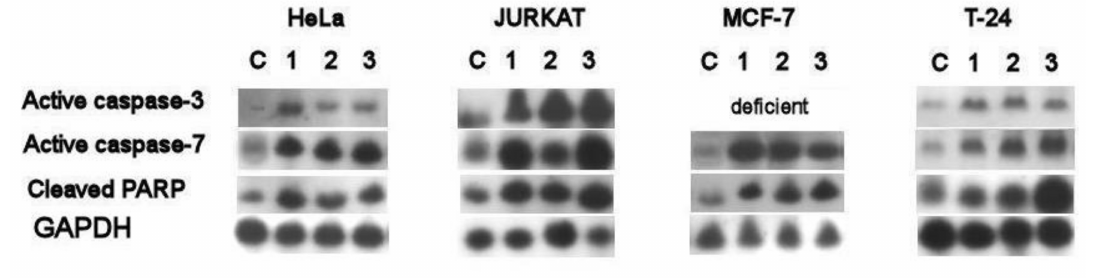
Figure 4. Western blot analysis of active caspase-3, caspase-7 and cleaved PARP using bark extracts (IC 50 ) of C. speciousa (1), T. cuspidata (2), and M. acuminnata